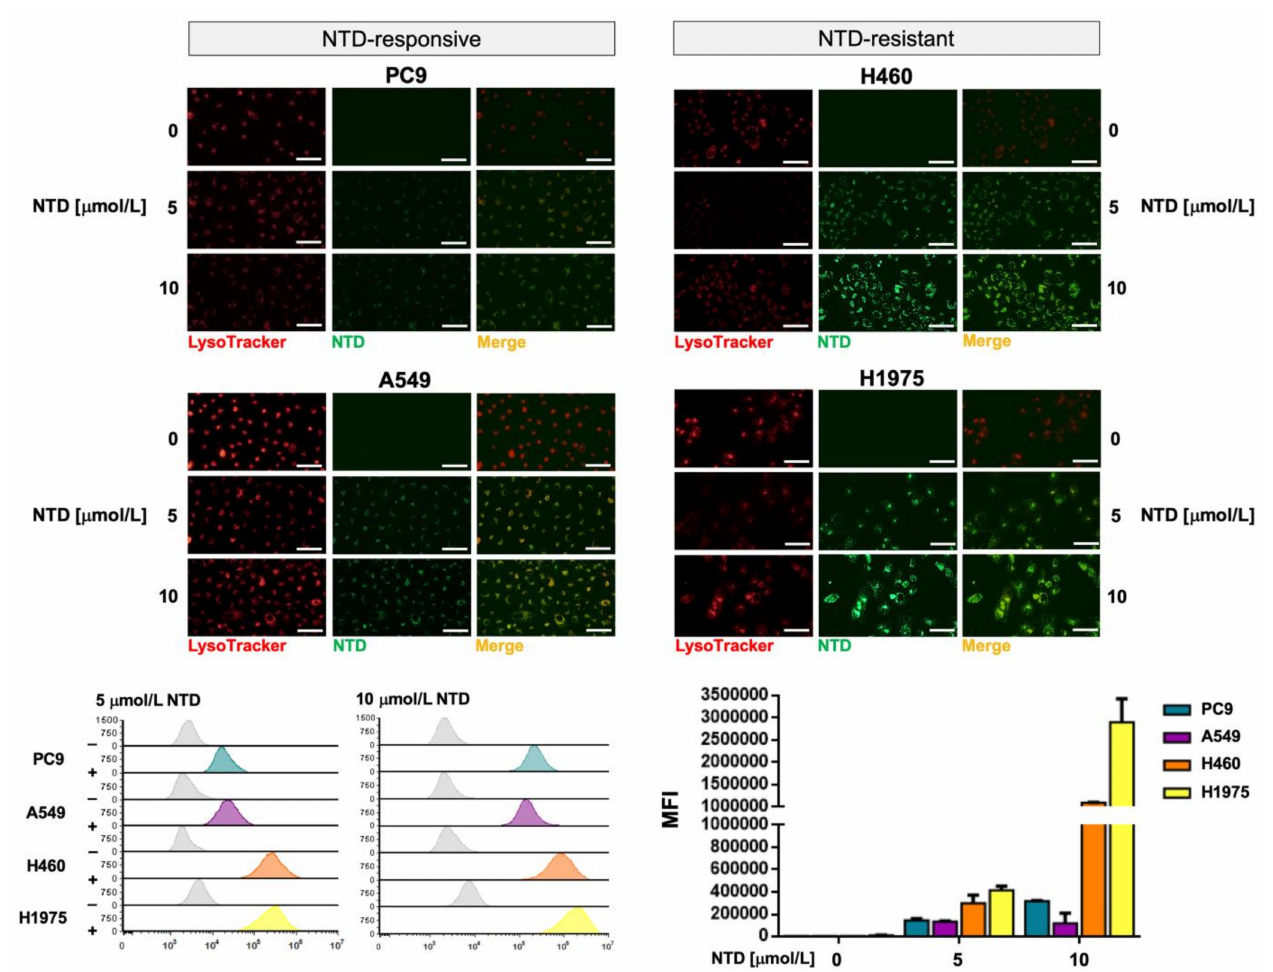
Figure 4. Lysosomal sequestration of nintedanib in NSCLC cell lines. Top. Subcellular distribution of 5 and 10 µ mol/L nintedanib in PC-9, A549, H460 and H1975 cells after 3 h drug exposure was analyzed by live cell fluorescence microscopy in the FITC channel. LysoTracker ® Red served as a marker for the lysosomal compartment. Nintedanib/LysoTracker ® spatial overlap is also shown. The scale bar indicates 50 µ m. Bottom. Dose-dependent green fluorescence activity of nintedanib (NTD) in NTD-responsive PC-9 and A549 cells and in NTD-resistant H460 and H1975 cells was analyzed by flow cytometry. Each experimental value represents the mean NTD-associated fluorescence ( columns ) ± S.D. ( bars ) of 3 independent experiments. (MFI: Median Fluorescence